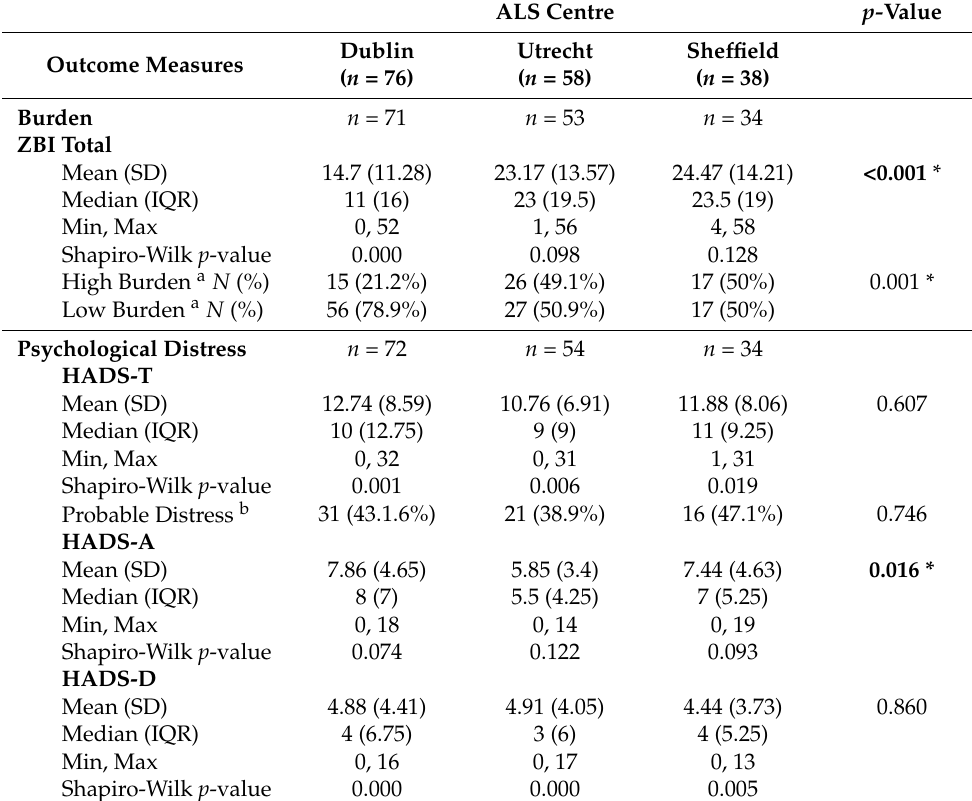
Table 2. Caregiver Wellbeing